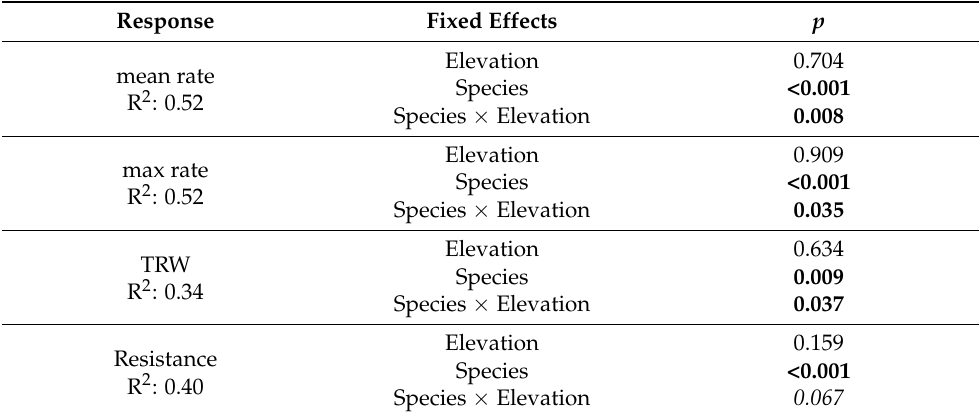
Table 4. p -values of ANOVAs based on LMMs with mean daily growth rate, maximum daily growth rate and tree-ring width as response variables, tree species and elevation as fixed main and interaction effects and plot nested in transect as random effect.